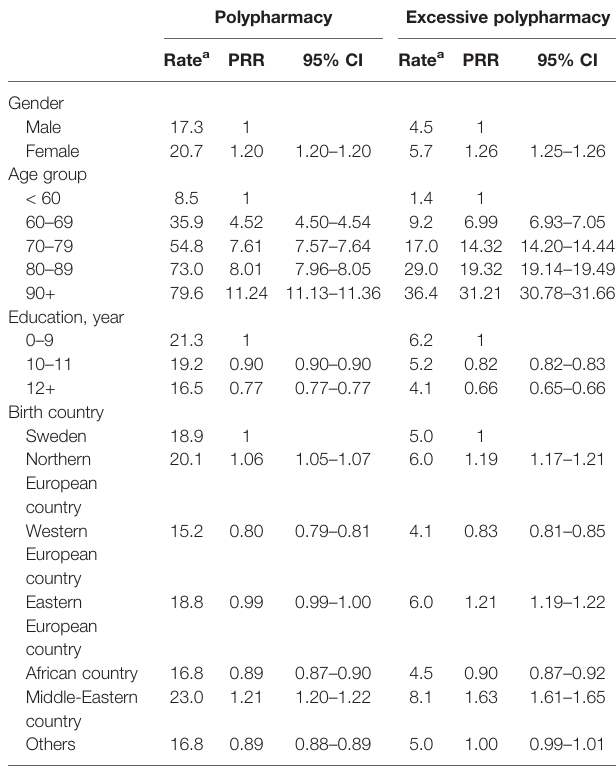
TABLE 3 | Prevalence rate ratio of polypharmacy and excessive polypharmacy in 2014.